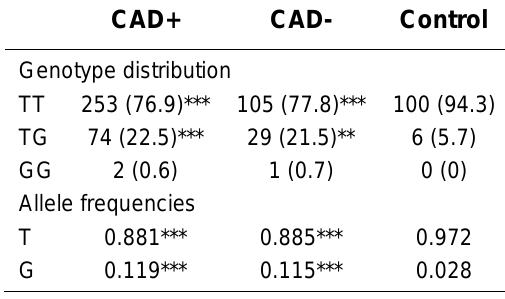
Genotype Distribution and Allele Frequencies of SNP +45T/G in CAD+, CAD-, and Control Subjects CAD+ CAD- Control